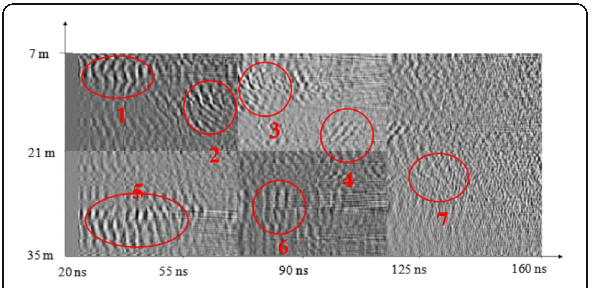
Fig. 18 Second measurement from top to